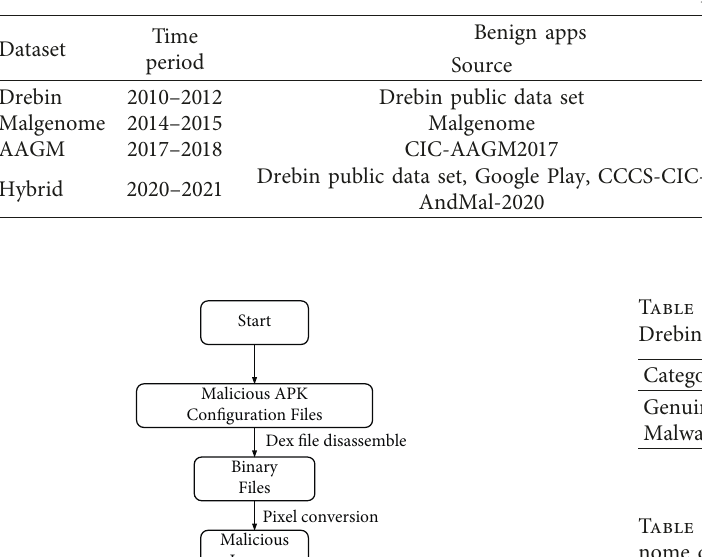
Table 1: Data set description.